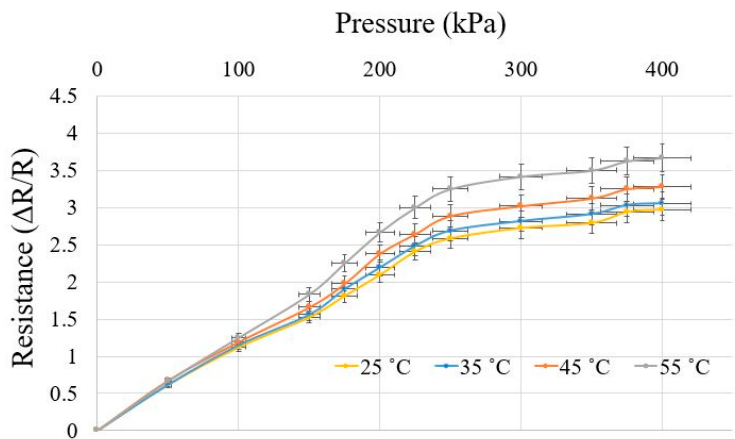
Figure 10. The response of the sensors with respect to the change in pressure for four different temperatures of 25 ◦ C, 35 ◦ C and 45 ◦ C and 55 ◦ C.